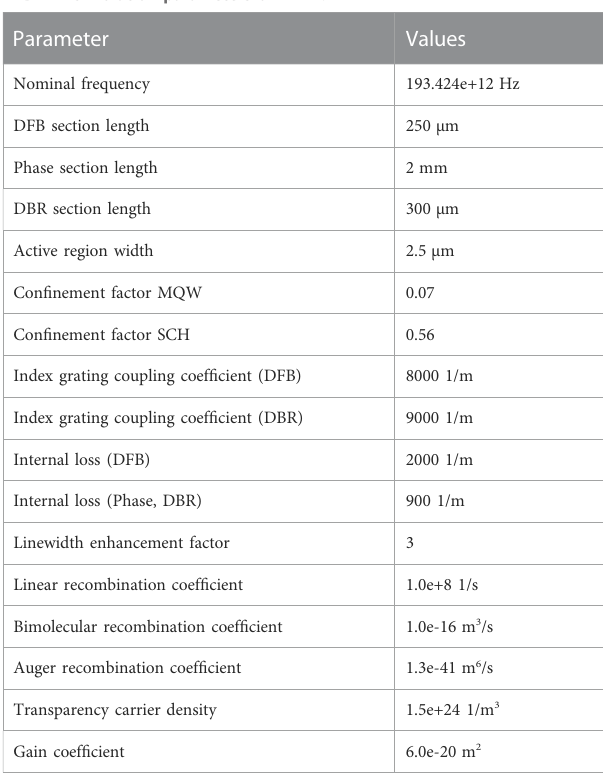
TABLE 1 Simulation parameters of